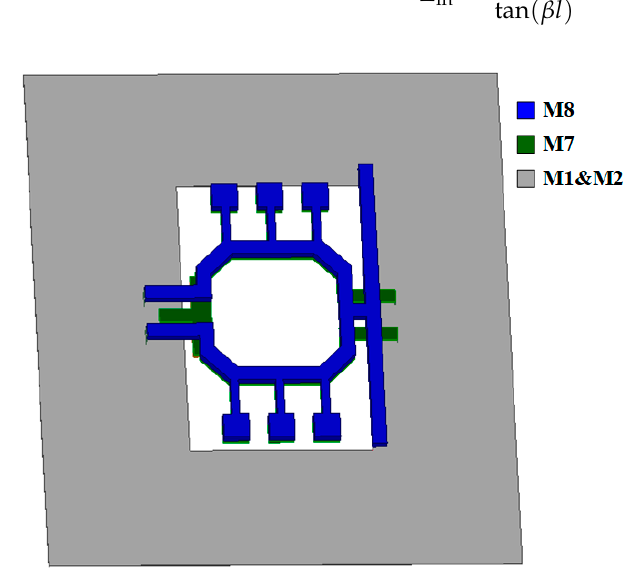
Figure 9. The transformer model in the E-M software.